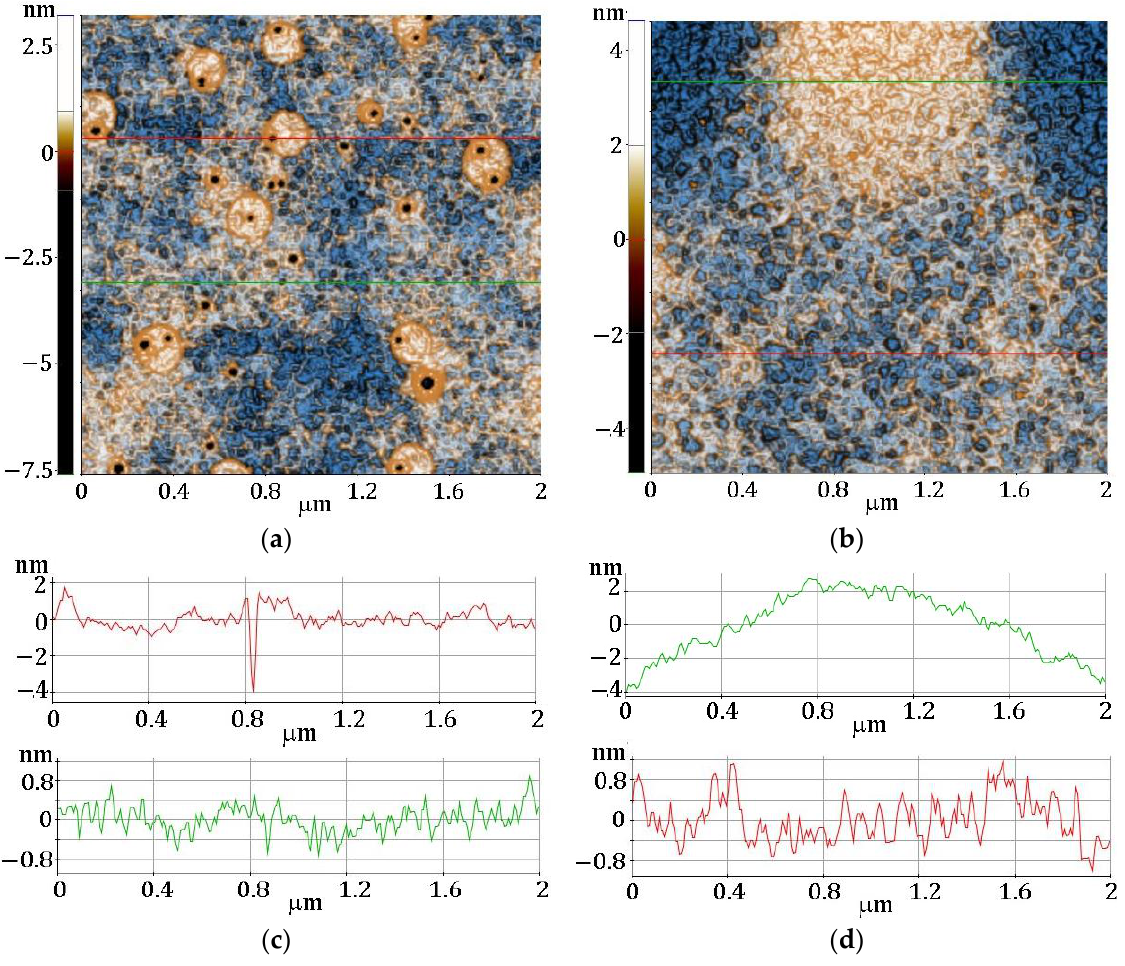
Figure 6. 2D AFM images (enhanced contrast) scanned over 2 µm × 2 µm together with two representative line scans collected along the green and red lines (the positions are indicated in each AFM figure) for fluorinated hybrid coatings: sample F1 ( a , c ) and sample F2 ( b , d ).